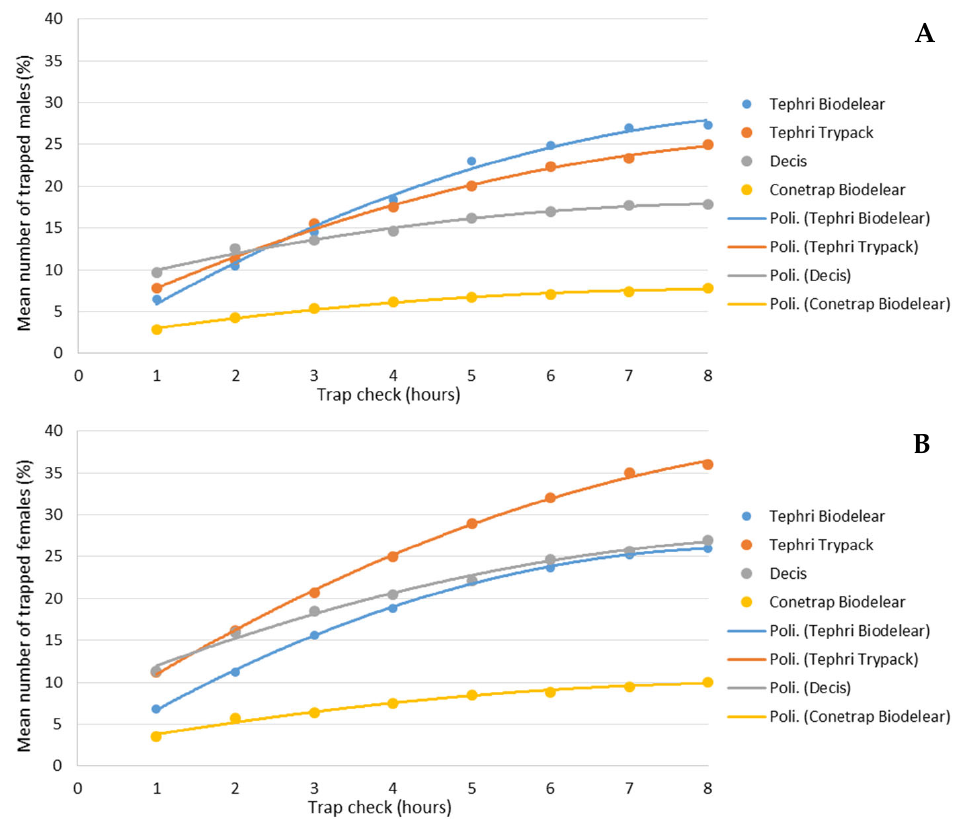
Figure 4. Cumulative captures of male ( A ) and female ( B ) catches (in %) over the 8 ‐ h trial period in the four trapping devices.